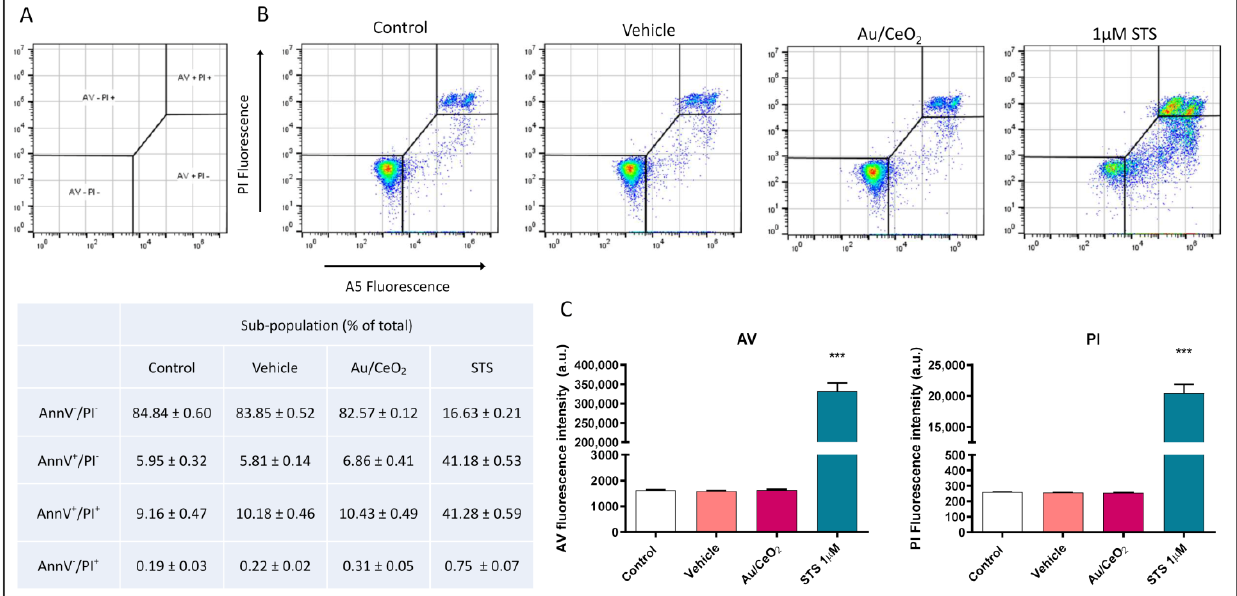
Figure 8. Assessment of apoptosis in U937 cells. ( A ) Diagram of the gating showing all the populations for each histogram. ( B ) Representative histograms (Bivariate Annexin V/PI analysis) of untreated cells, vehicle (DMSO), Au/CeO 2 treatment and positive apoptotic control (1 µM STS) demonstrating the existence of 4 cellular sub-populations: AnnV − /PI − , AnnV+/PI − , AnnV − /PI+ and AnnV+/PI+. Table shows the percentage of each sub-population for every condition studied (Mean + SEM). ( C ) Summary of Annexin V and PI fluorescence data. Data (mean + SEM) were analysed by Student´s t test. Significance *** p < 0.001 vs. Untreated.